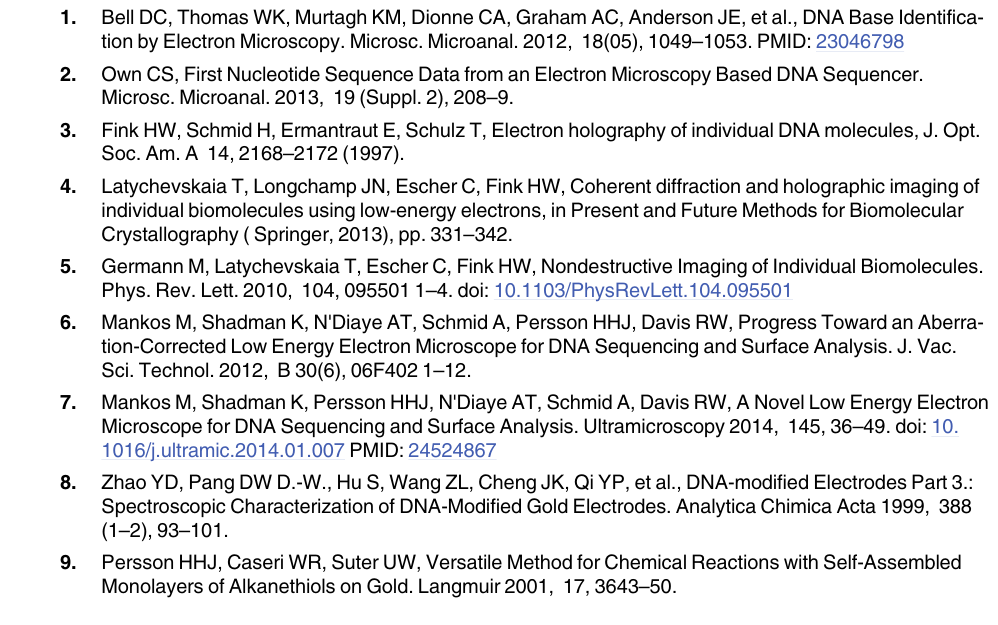
S1 Fig. High-resolution P 2p XPS spectra for single-stranded homopolymeric 20mers. All spectra have been peakshifted to 133.6 eV and scaled to the same height. The obtained peak- shift and scaling factor were used for normalization of all other elements throughout each sam- ple. S2 Fig. Peak-fitted high-resolution N 1s XPS spectra for single-stranded homopolymeric 20mers. The data for all samples are fit with one peak for single-bonded nitrogen at 400.6 eV. In addition the Adenine, Cytosine and Guanine samples are fit with a second peak at 399.5 eV corresponding to double-bonded